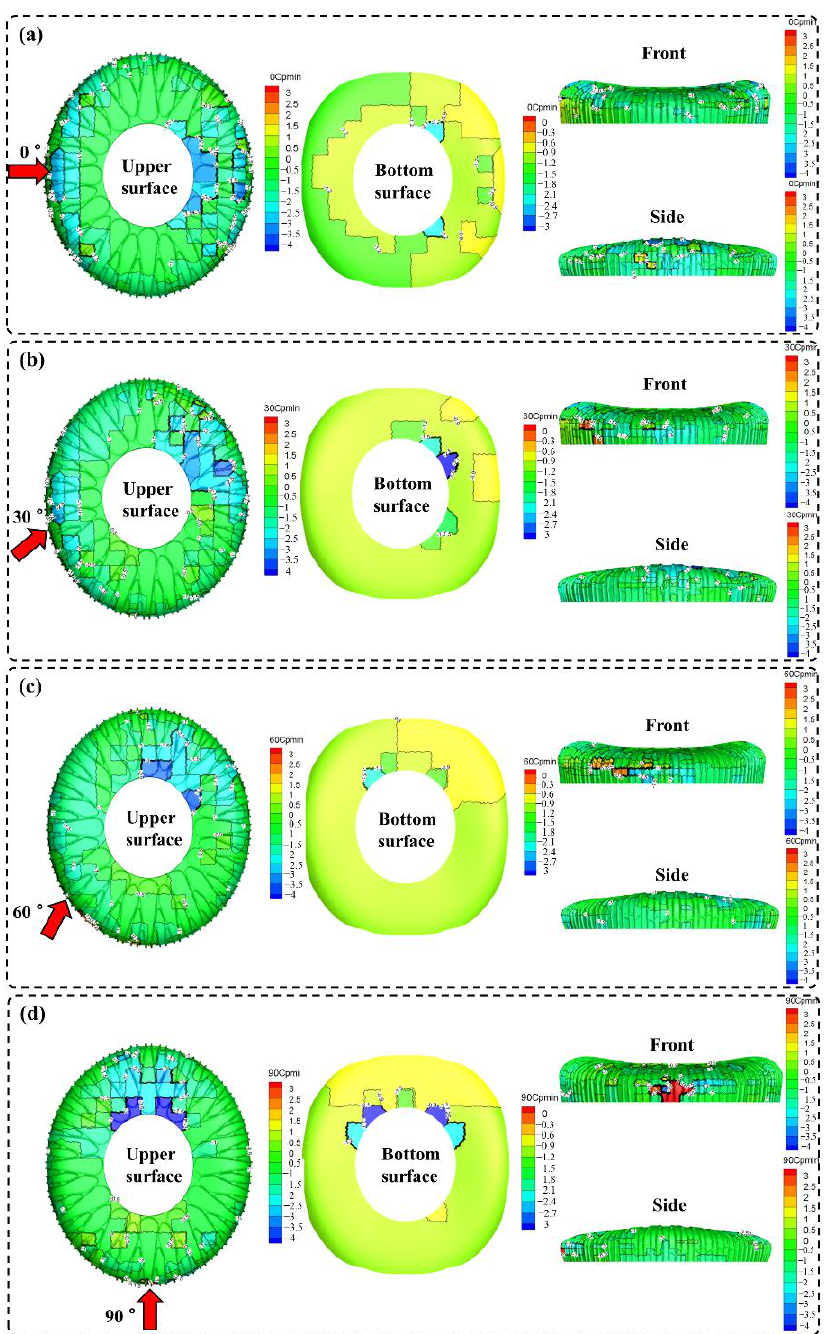
Figure 16. Minimum value of wind pressure coefficient at each wind direction angles for working case 1: ( a ) 0°; ( b ) 30°; ( c ) 60°; ( d ) 90°. Comparing the minimum values of wind pressure coefficients at 0°, 30°, 60°, and 90° wind angles for working case one, it can be seen that: (1) the wind pressure coefficients in the upper surface area of the roof are also all less than zero. At 0° and 30° wind angles near the edge of the windward area, its values are about −3, and −4 at 60° and 90°. This is because the open prefabricated spatial grid structure is saddle-shaped; at 0° and 30° wind